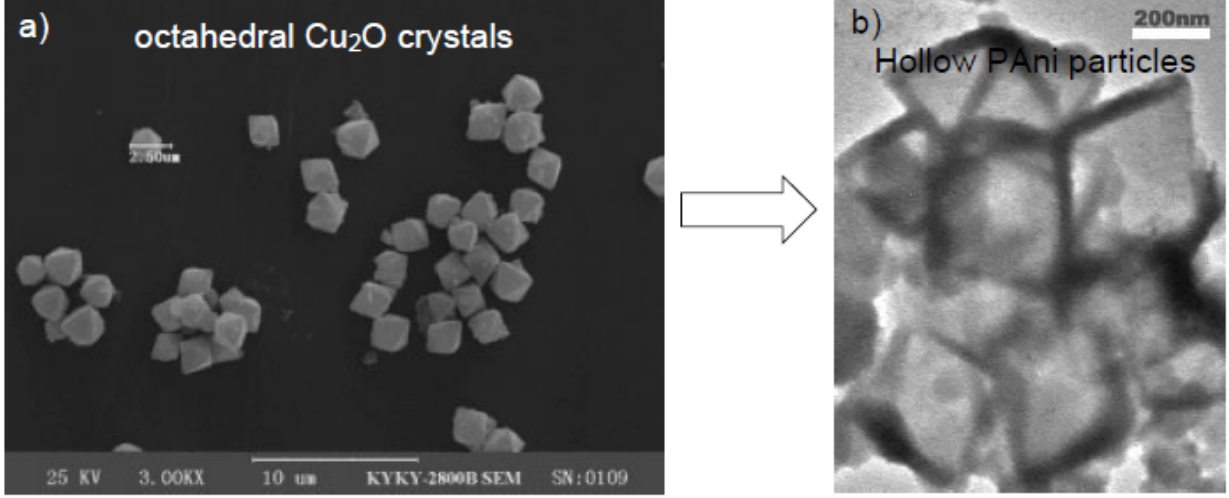
Figure 4. Polyaniline hollow particle fabricated by the hard template method. a ) Scanning electron microscopy (SEM) image of Octahedral Cu hollow particle replicates. Reproduced with permission from Wiley-VCH Verlag